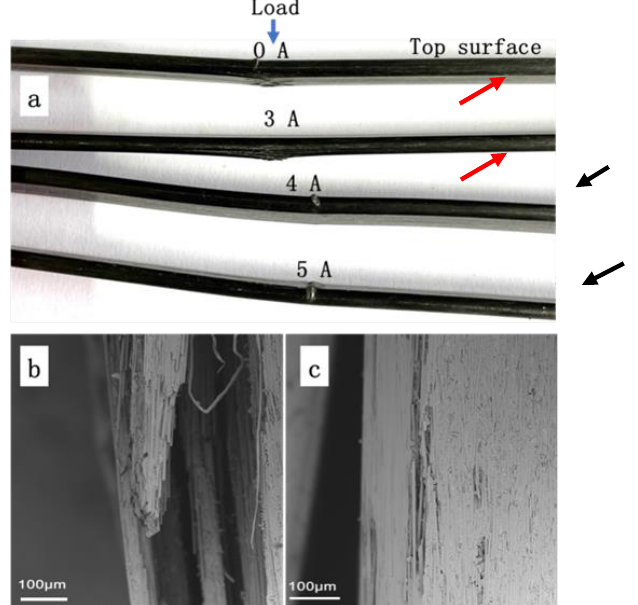
Figure 5. The photographs of the CF/EP composite plates after the 3-point bending tests. ( a ) Digital photographs of side view of the composites loaded with different electric current; SEM image of the bottom layer of the CF/EP composite under ( b ) 3 A and ( c ) 5 A.